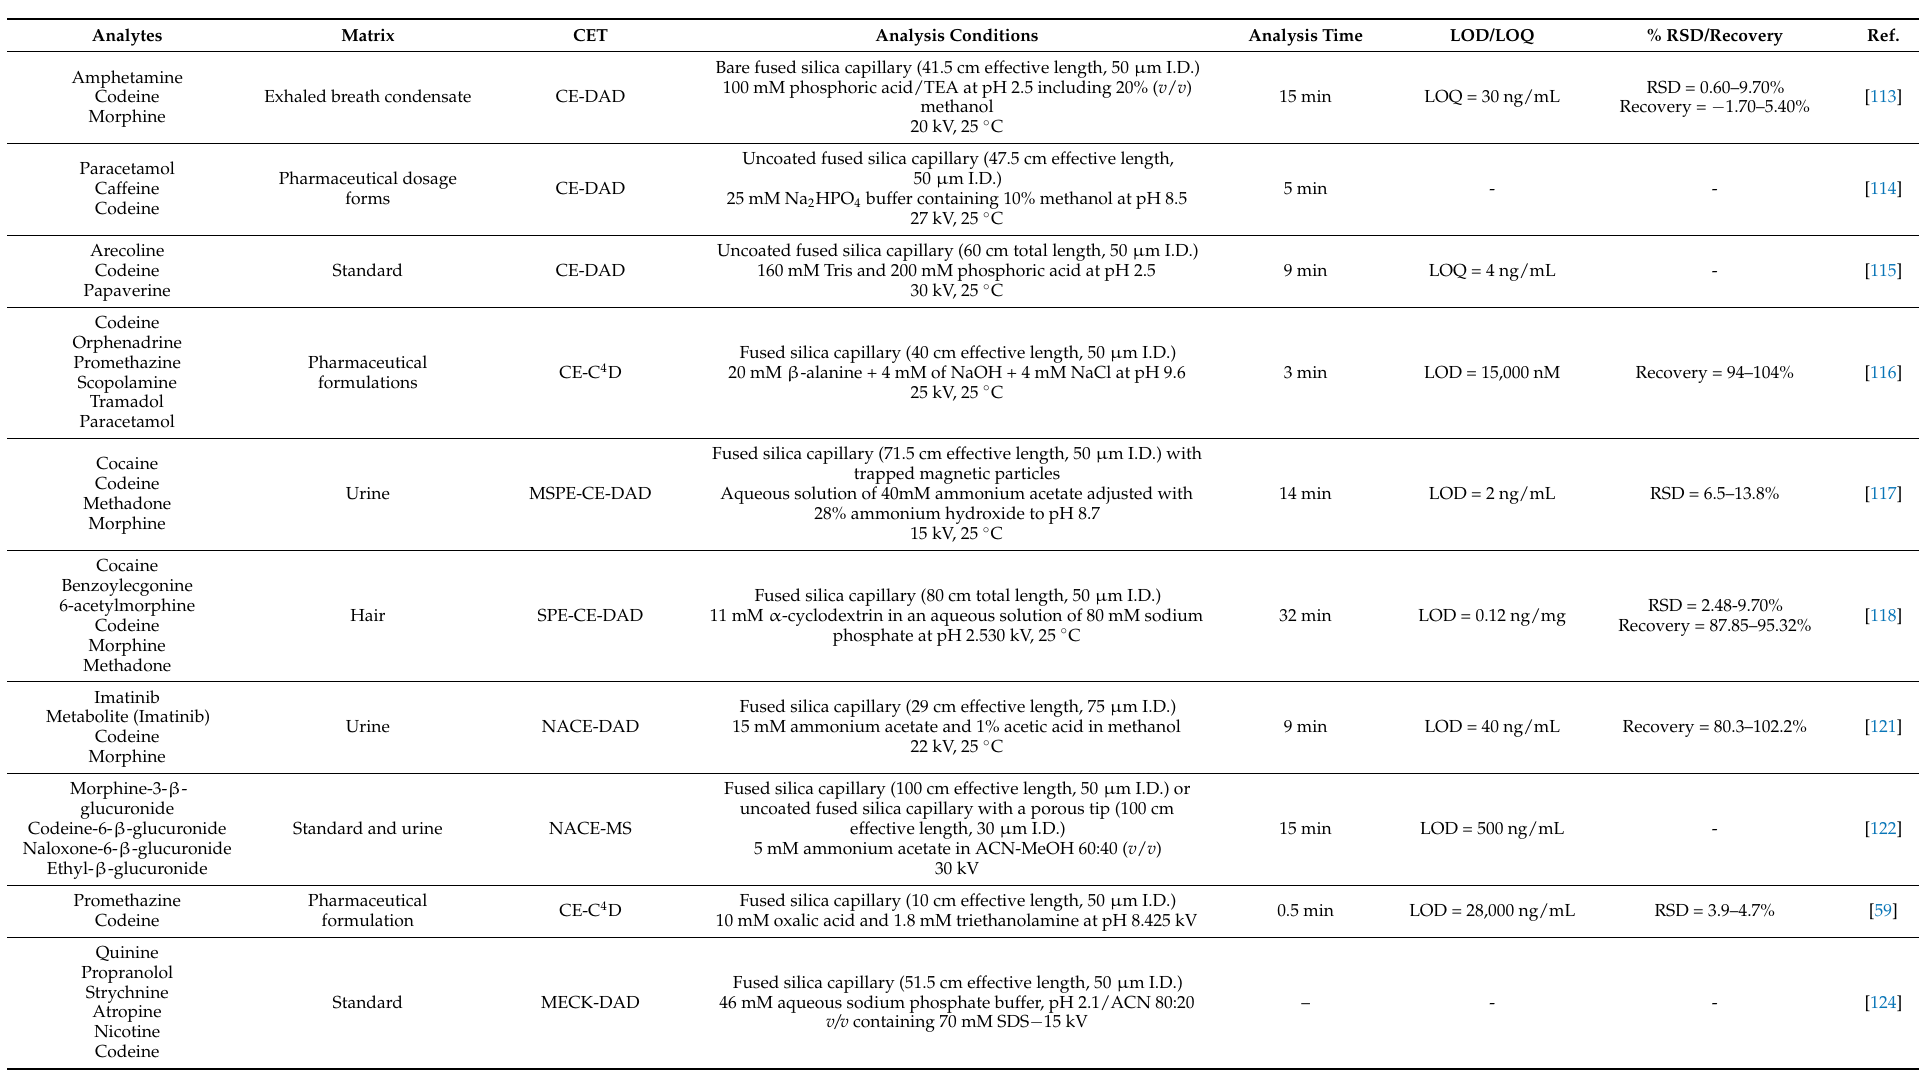
Table 5. Capillary electromigration techniques for analysis of